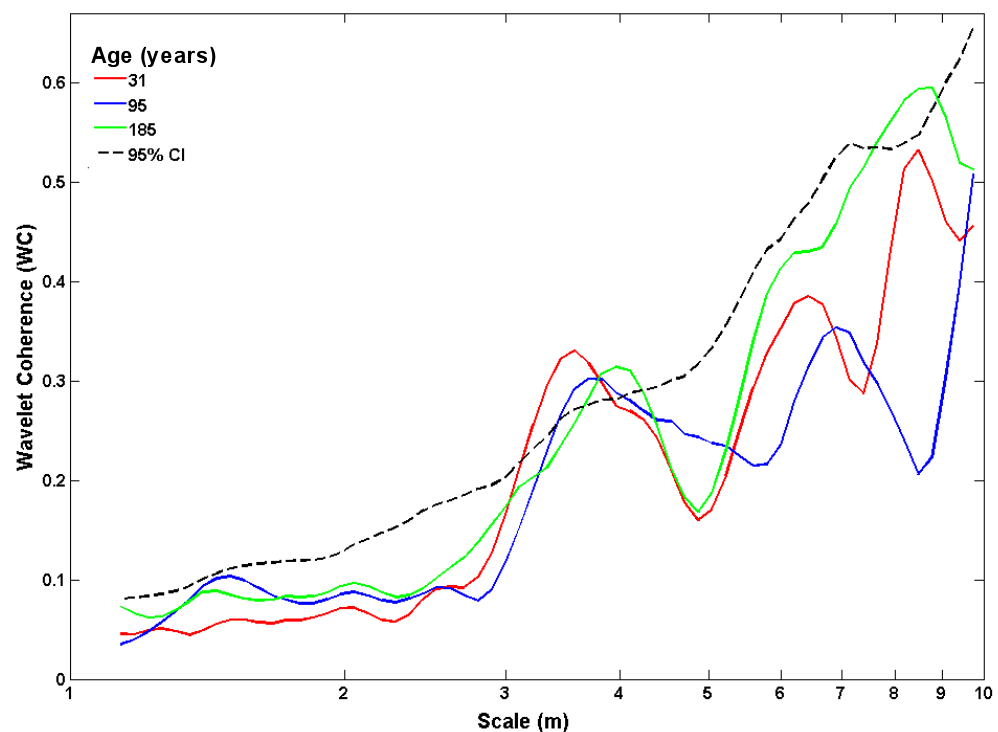
Figure 4. Roots and canopy structural coherence. Wavelet coherence between canopy height and root biomass peaks in all stands at 3–4 m and again at 8 m in the oldest stand. Each line is an average across all six transects in each stand. Confidence intervals were constructed from 1000 randomizations of six random samples independently extracted from the dataset pooled across sites. Portions of each curve above the dotted line indicate scales at which root biomass and canopy height are significantly coherent. Note that the x-axis is a shown on a log scale.